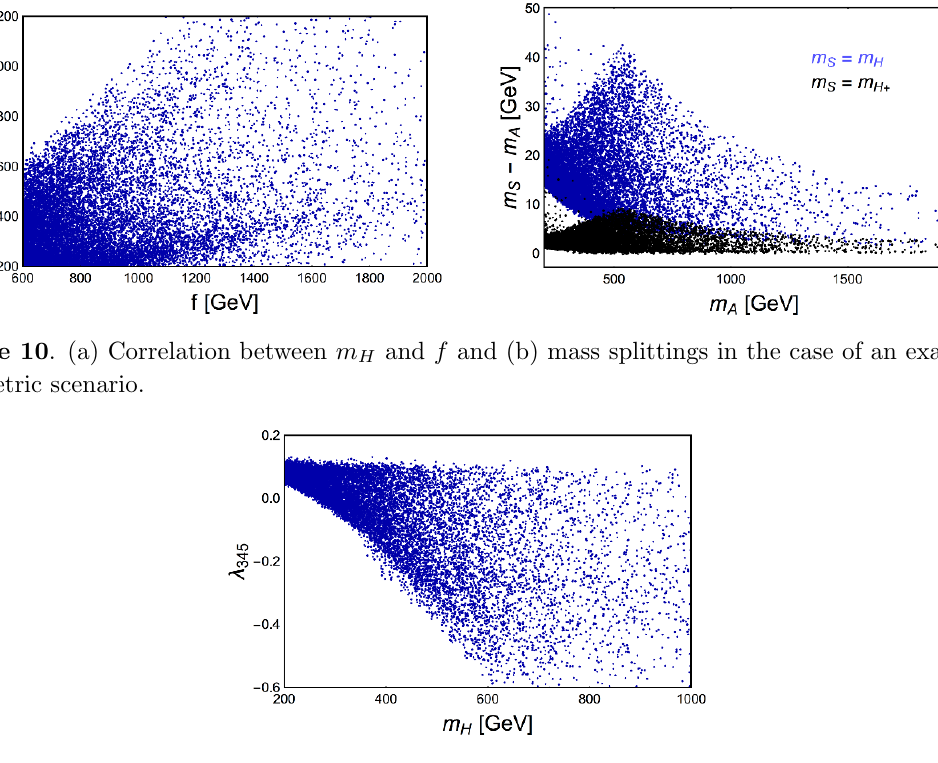
Figure 11 . Correlation between the coupling (cid:21) 345 and the mass of the inert doublet m H in the C 2 symmetric